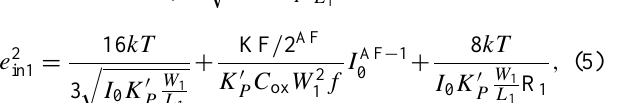
Figure 3. Photographs of the low noise ASIC amplifier named